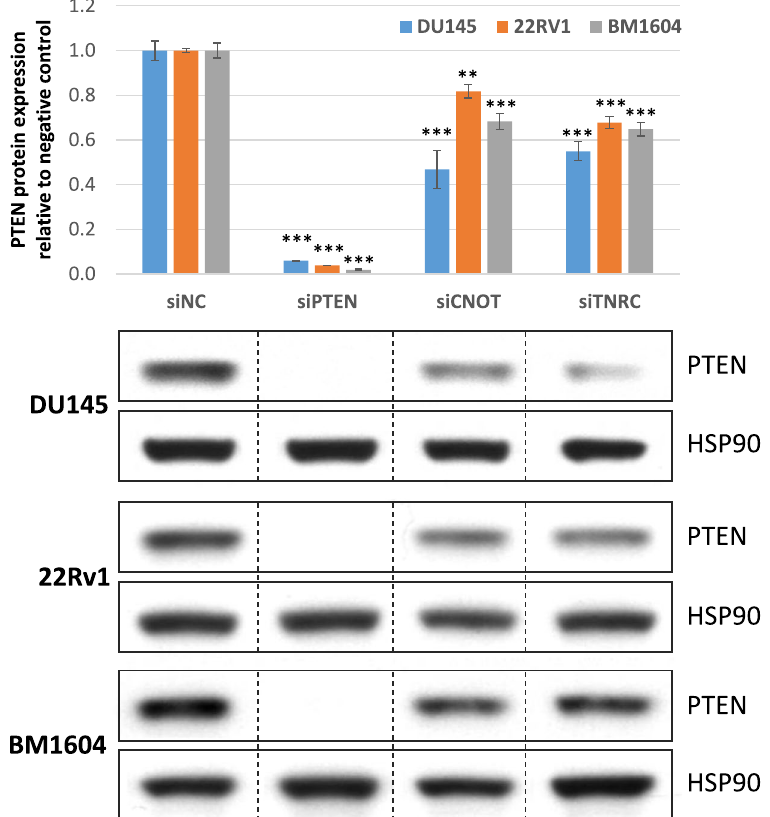
Figure 5. Predicted PTEN ceRNA TNRC6B modulates PTEN expression. Western blot for PTEN protein levels in prostate cancer cell lines transfected with siRNA against predicted ceRNA TNRC6B (siTNRC), validated ceRNA CNOT6L (siCNOT), PTEN (siPTEN) and a non-targeting control (siNC). Quantitation of the western analyses is shown above, and representative blots